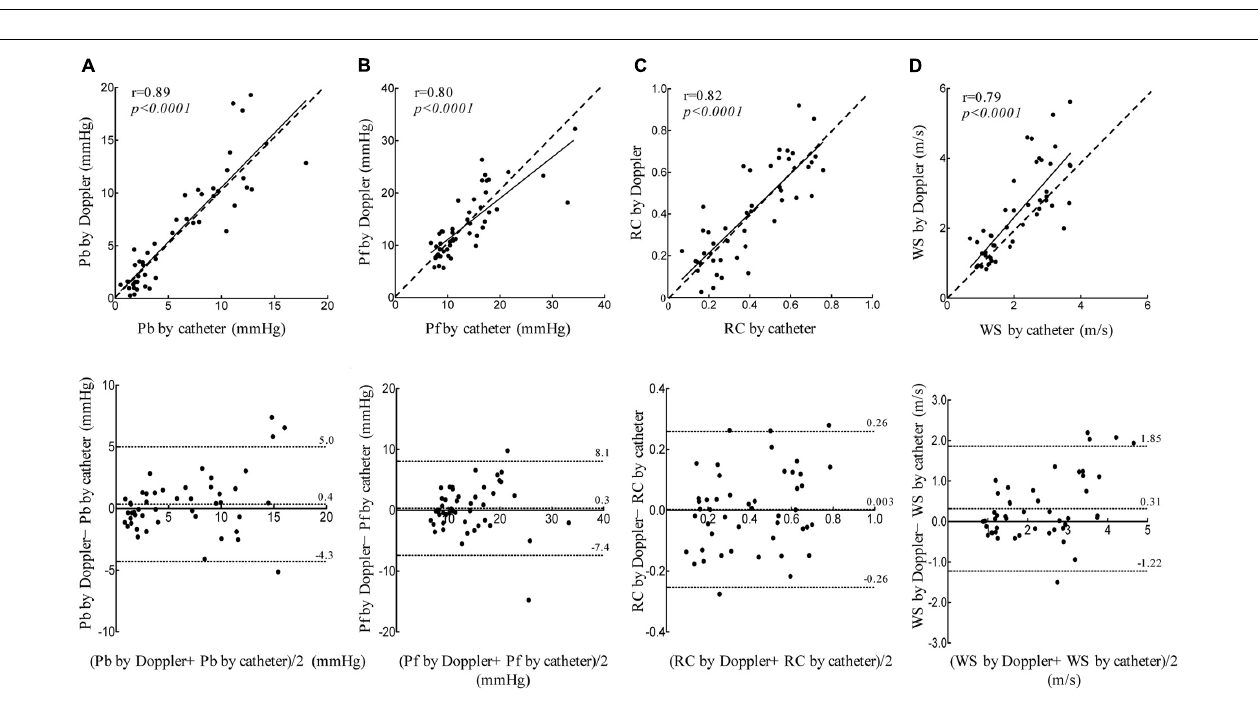
FIGURE 2 | Comparison between catheter derived and Doppler derived separated pressure waveforms. Separated pressure waveforms obtained using direct pressure and flow measurements acquired from one sample dog (left side) and those obtained using echo-Doppler images of RVOT and TR flows from the same dog (right side). Pt, Pf, and Pb denote pulse pressure, forward pressure and backward pressure, respectively.